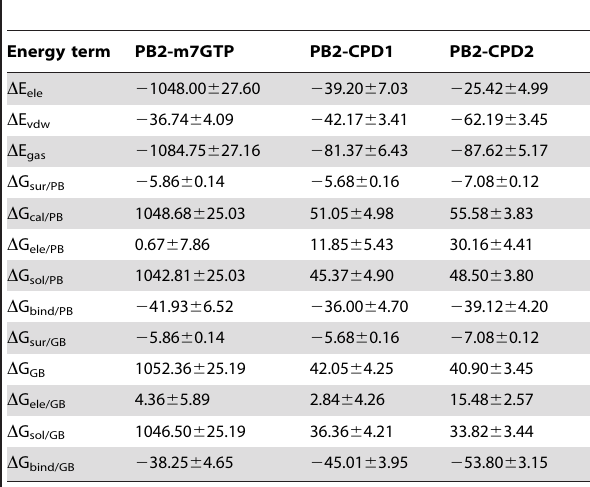
Table 1. Binding free energies (kcal/mol) of m7GTP and other ligands calculated from both MM-PB/SA and